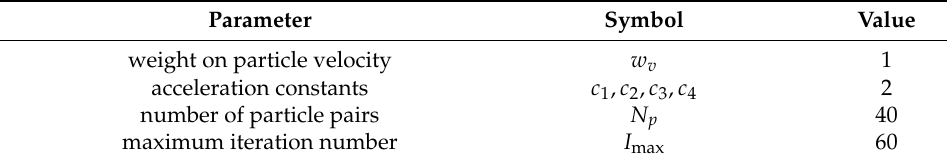
Table 9. Parameters of P 2 SO algorithm. Parameter Symbol Value weight on particle